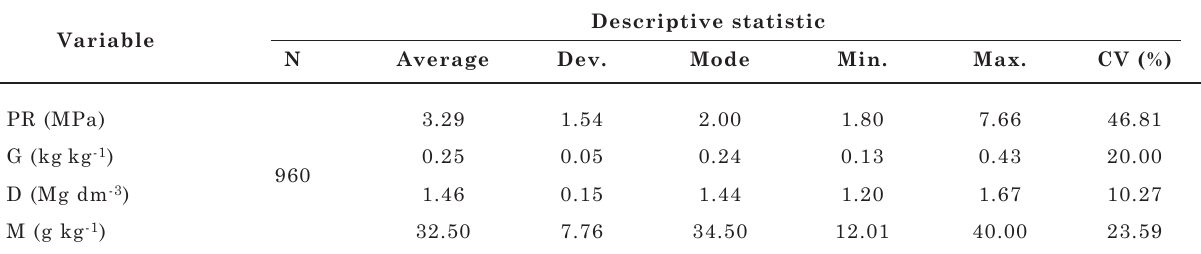
table 2. descriptive statistics for the variables analyzed at depths of 0–20 cm in eutroferric red oxisol under annual no-till